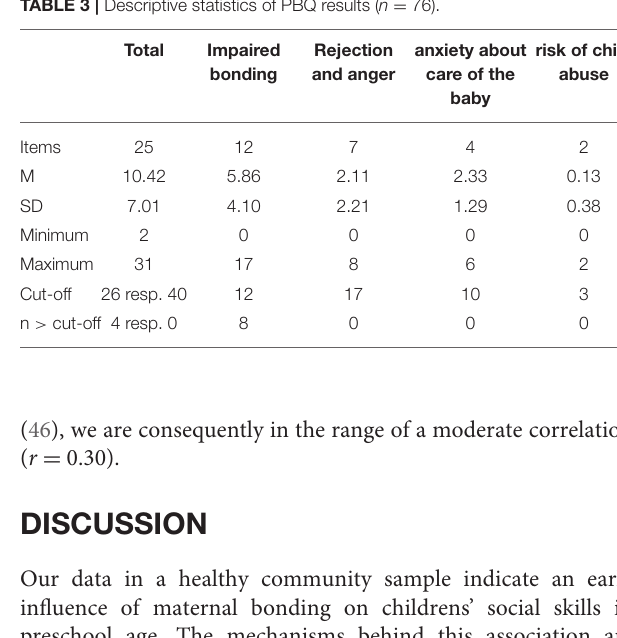
TABLE 3 | Descriptive statistics of PBQ results ( n =